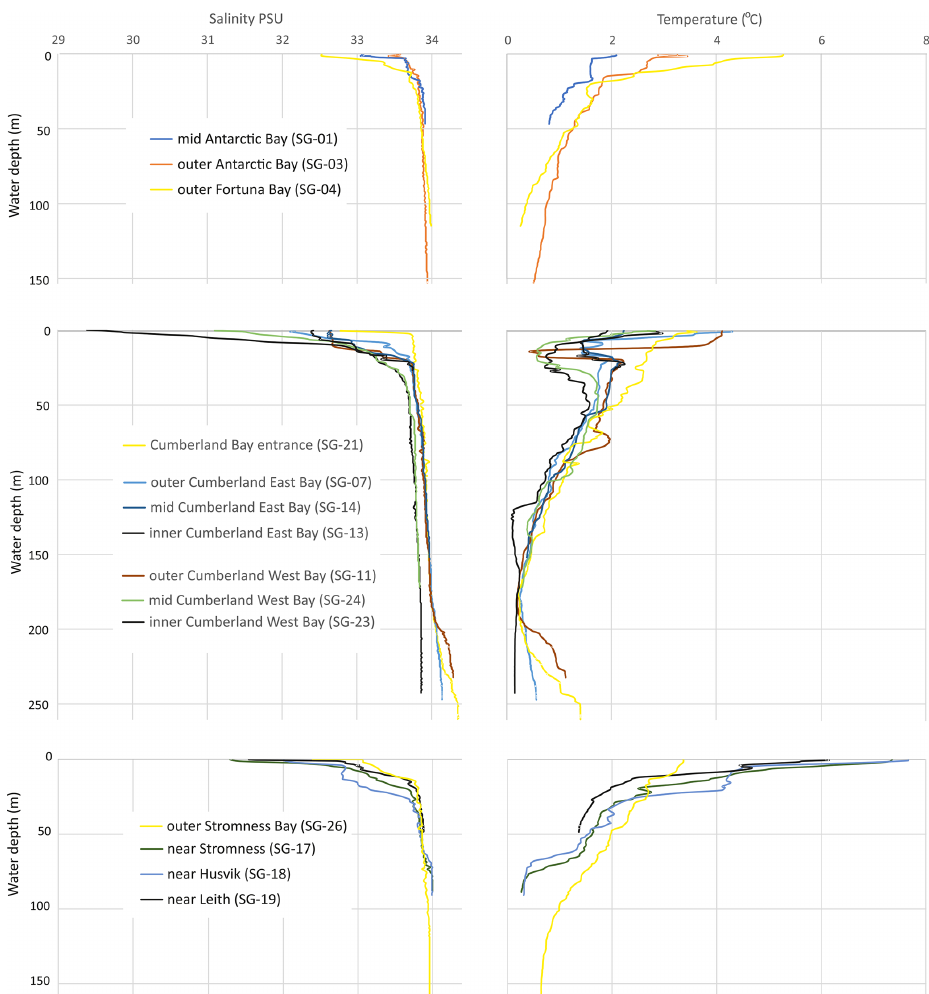
Figure 2. Selected salinity and temperature profiles from Antarctic, Fortuna, Cumberland, and Stromness bays in South Georgia. The loca- tions of the CTD profiles are indicated in Fig. 1 and in Table